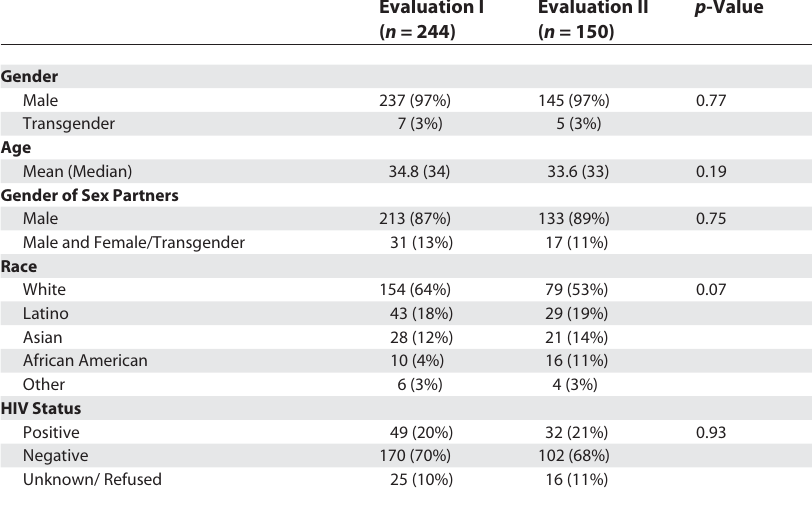
Table 1. Demographic Characteristics of Respondents from First and Second Evaluations of the Healthy Penis